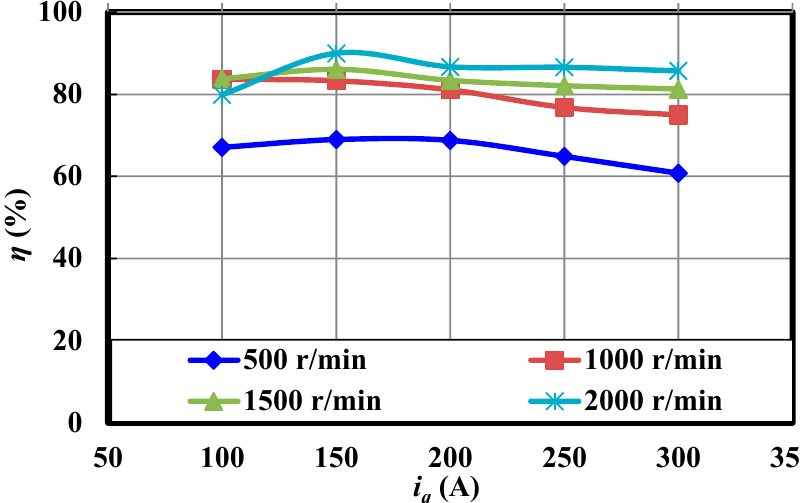
Figure 23. E ffi ciency versus current and speed (including three-phase inverter e ffi ciency).